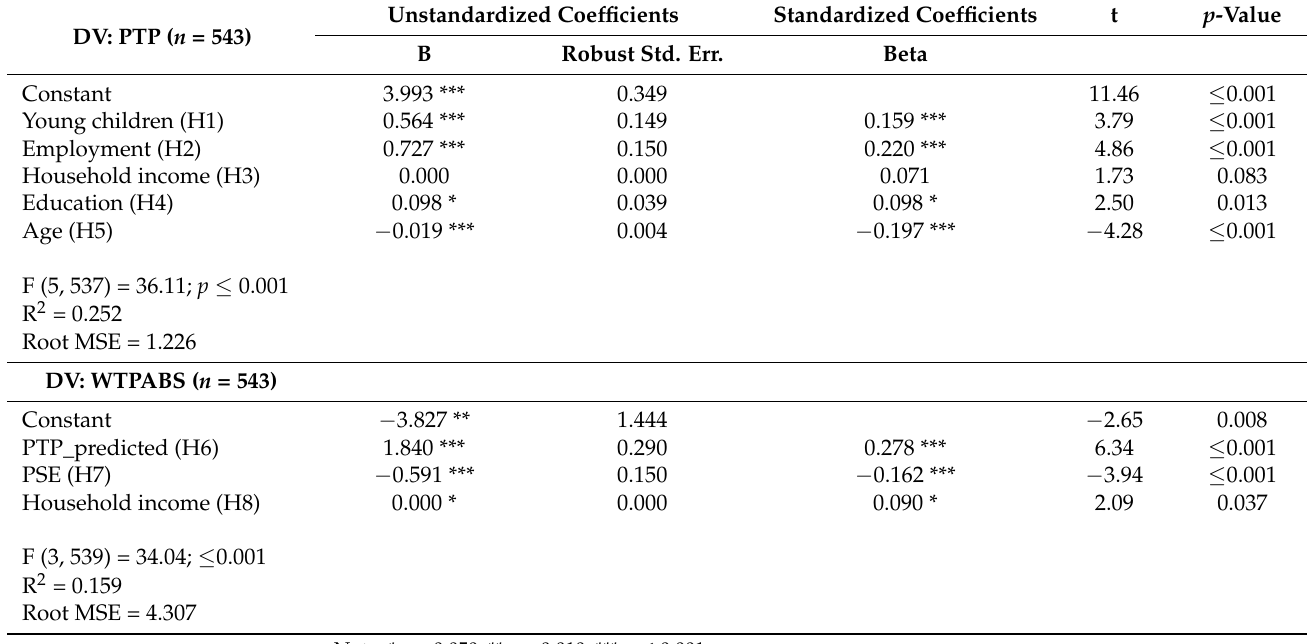
Table 3. Results for the full